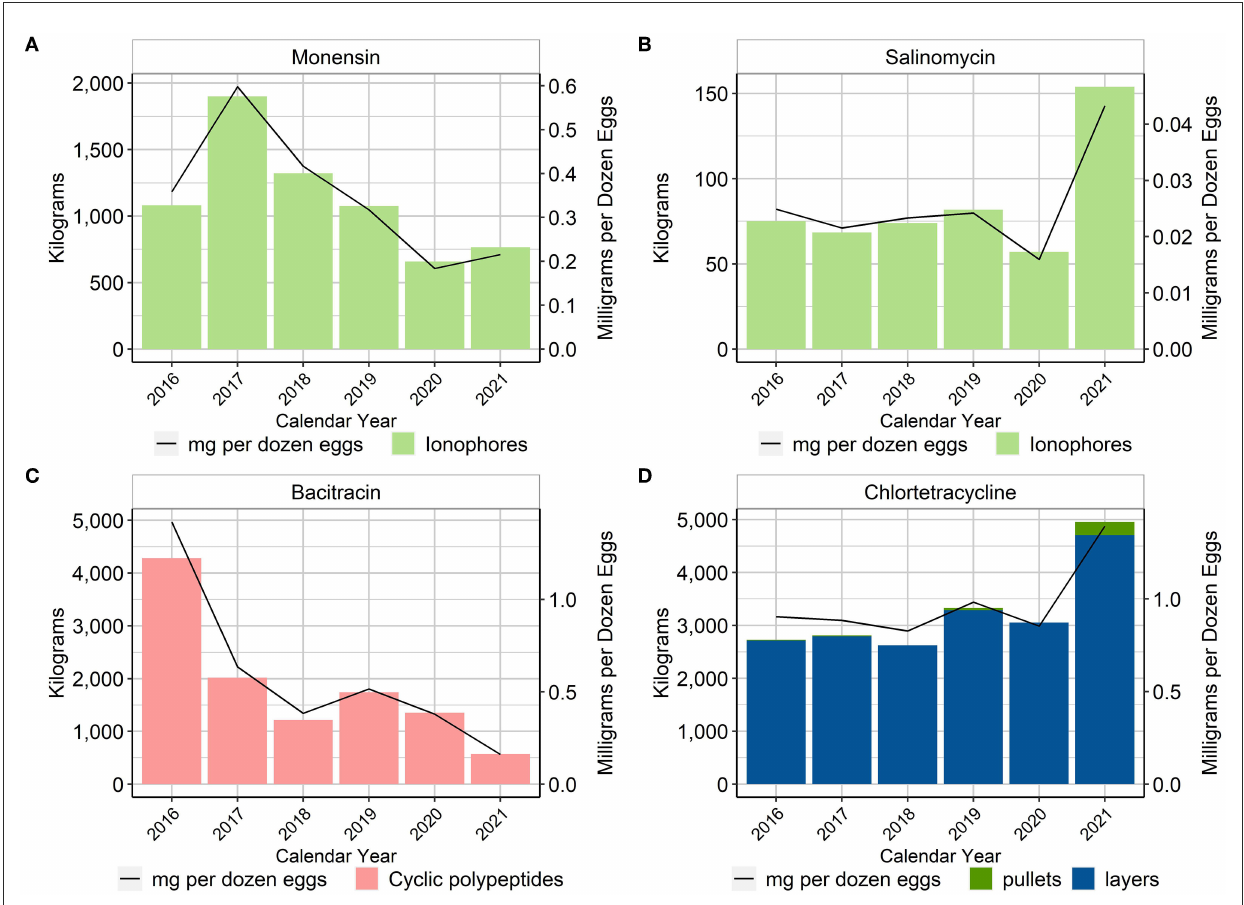
FIGURE2 Monensin (A) , salinomycin (B) , bacitracin (C) , and chlortetracycline (D) used in layer feed, 2016–2021. Total kilograms are shown by the bars (left Y-axis) and total mg/dozen eggs produced are shown by the line (right Y-axis). Total kilograms of chlortetracycline are separated into pullet and laying hen use.